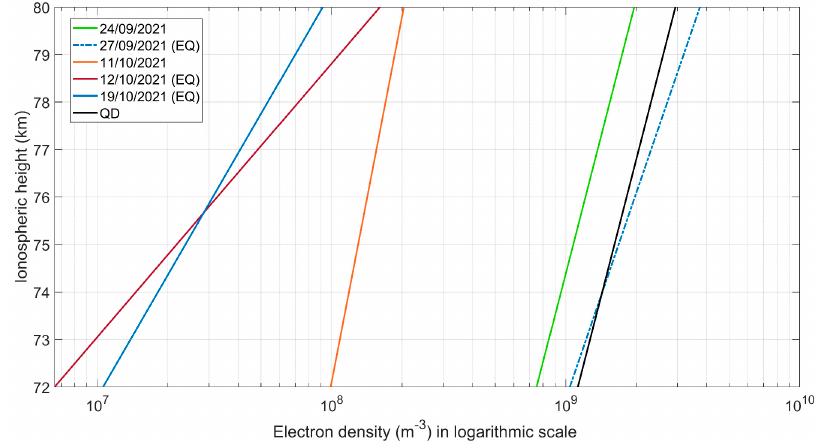
Figure 12. Altitude profile of ionospheric ED around the time of SRT1 obtained from ISR–GER path with respect to the 2021 Crete EQs. The y -axis and x -axis denote the ionospheric height in km and the ED in logarithmic scale, respectively. “QD” and “EQ” lines represent the variation of normal days and the EQ day, respectively.